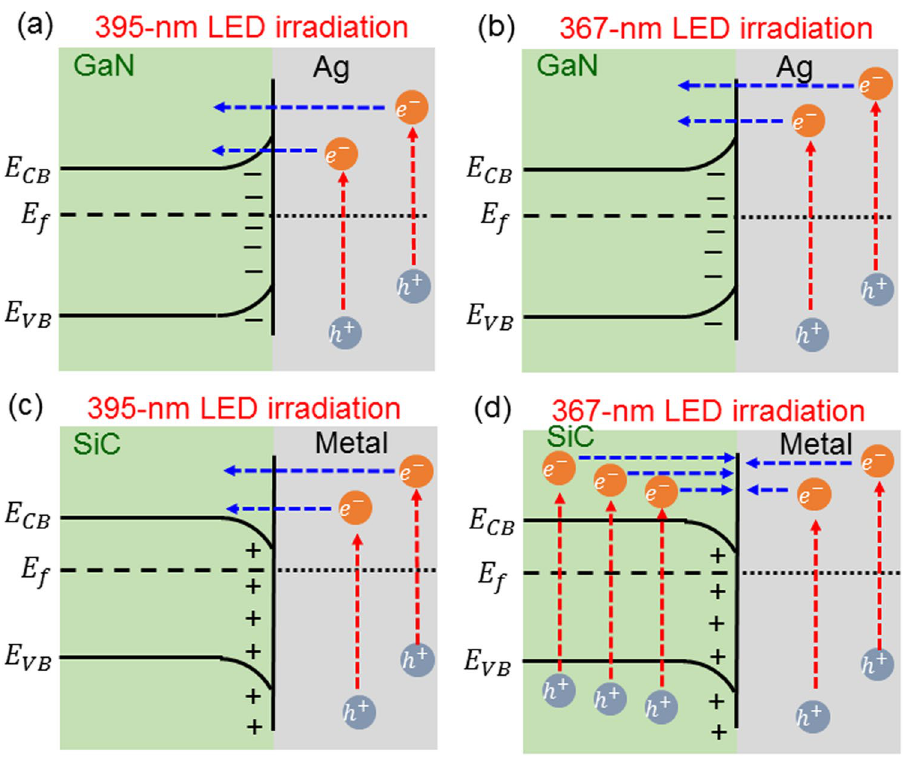
Figure 7. ( a–d ) Energy diagrams near the GaN/Ag and SiC/Ag interfaces when samples are illuminated by the 395- and 367-nm LEDs.